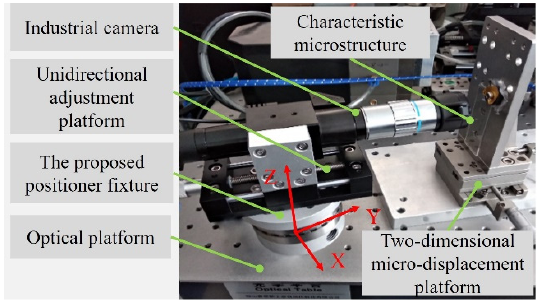
Figure 5. Experimental setup for the repeated positioning accuracy test.